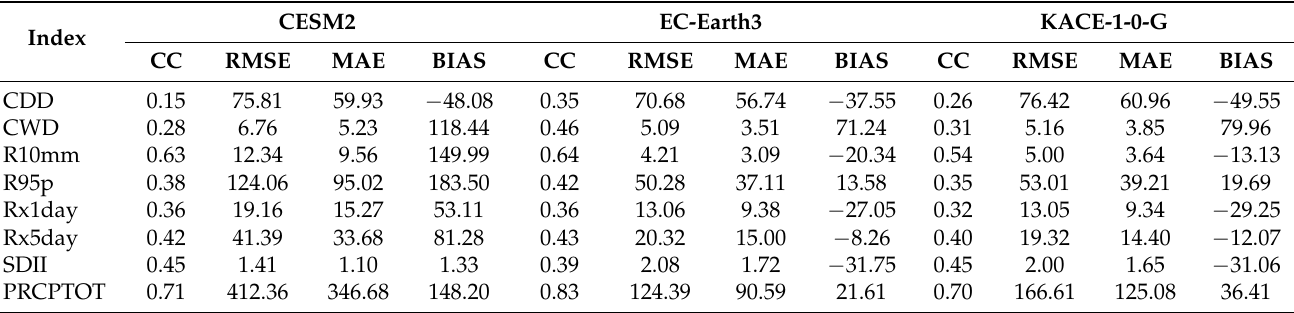
Figure 3. The Kling–Gupta efficiency (KGE) of spatial interpolation at seven weather stations. Table 3. Statistical errors of the eight extreme precipitation indices between the original CMIP6 models and the observed